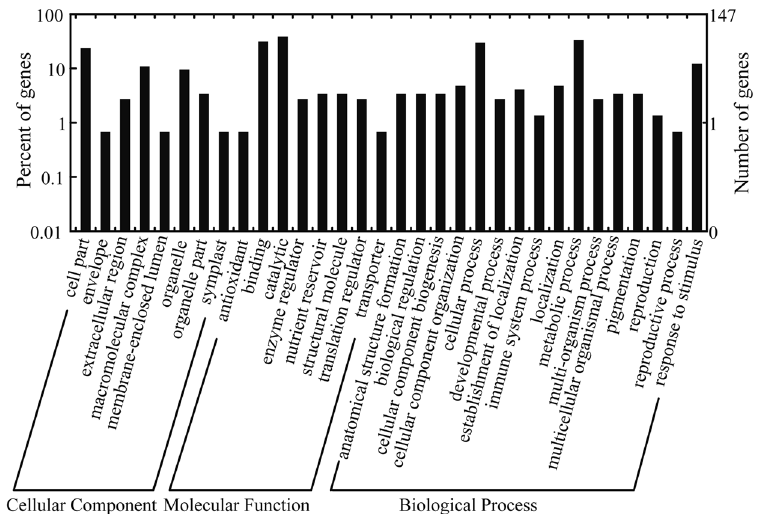
Figure 4. GO annotation of DEPs in PT and NT maize